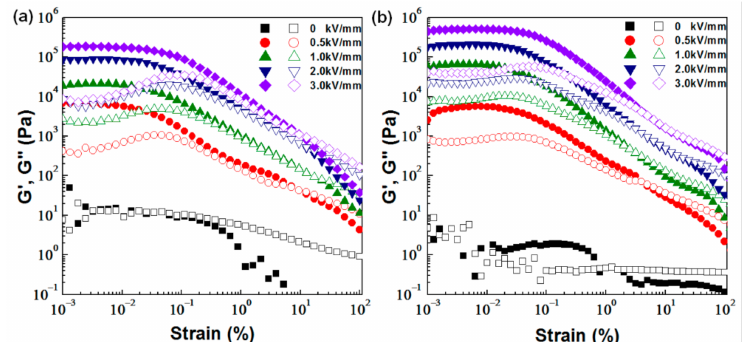
Figure 6. Amplitude sweeps of ER fluids based on cellulose ( a ) and cellulose/Laponite composite ( b ) measured at various electric field strengths (G’: closed symbol; G”: open symbol).